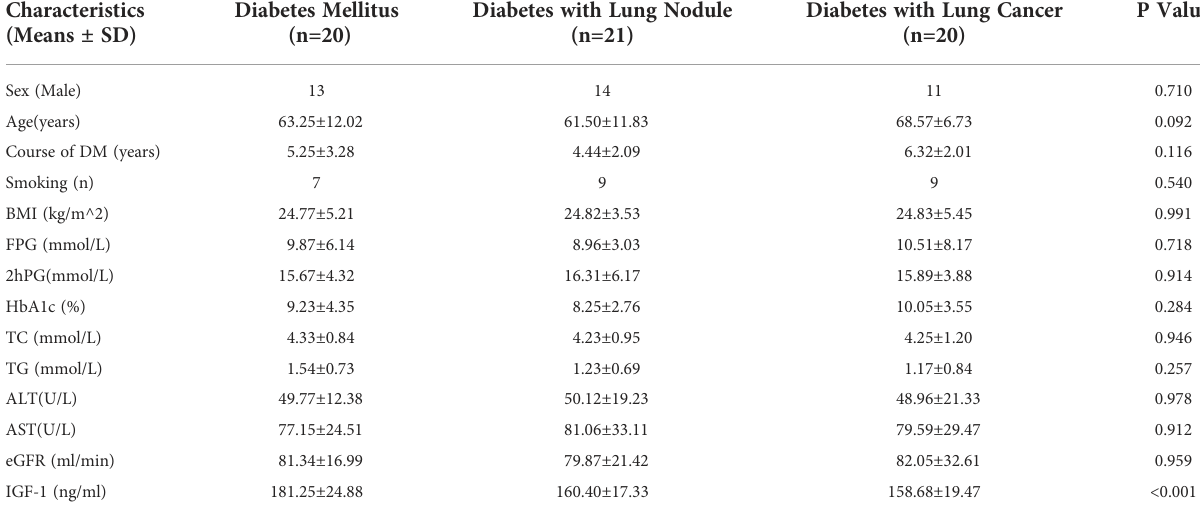
TABLE 1 General characteristics of the study